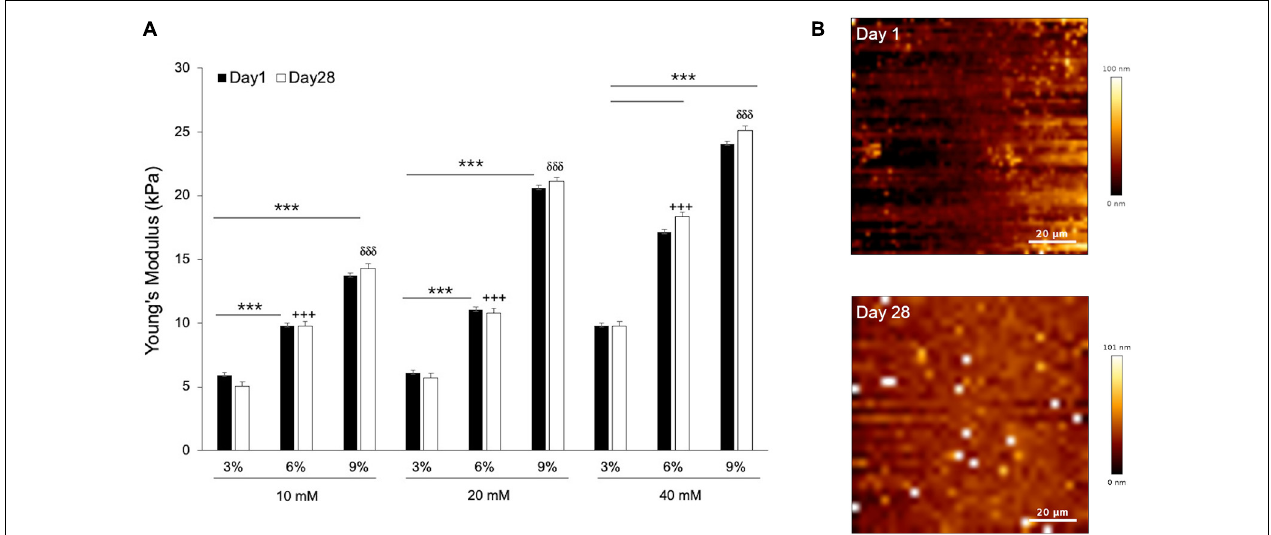
FIGURE 1 | The mechanical properties and topography of hydrogels scale with gelatin and genepin concentrations. (A) Gelatin hydrogels from 3, 6, and 9% (w/v) were crosslinked with 10, 20, and 40 mM genipin solution and cultured for up to 28 days. All values for Young’s Modulus were compared to controls (Day 1). Error bars represent SD for n = 18 replicates from three separate experiments, where comparisons between 3% vs. 6% are indicated with a cross (+ + +) and 3% vs. 9% with a delta ( δδδ ). (B) Surface of gelatin substrates scanned by AFM at Day 1 and Day 28. Student-test comparisons revealed *** P < 0.001. All other comparisons were not